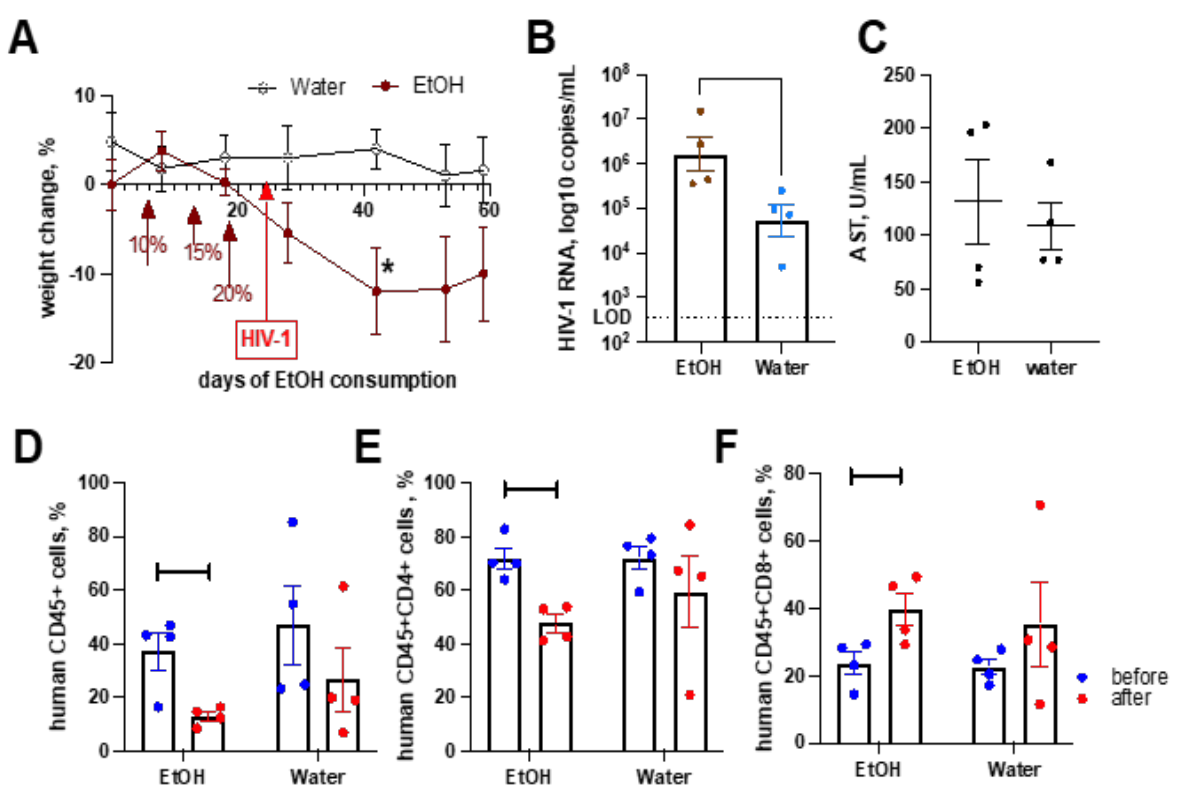
Figure 7. Alcohol consumption worsens HIV-1-induced immunopathology but does not change liver enzyme activity. ( A ) Humanized animals exposed to increased concentrations of alcohol in water showed a reduction in body weight compared to control mice kept on regular water. ( B ) Alcohol-consuming mice had a higher viral load in peripheral blood. ( C ) The activity of AST remained in the normal range, and ALT was the same at 49 U/mL in all animals. ( D – F ) Alcohol accelerated the development of immunopathology. The number of human cells in the peripheral blood of alcoholic mice dropped due to HIV-1 infection ( D ). The depletion of CD4+ cells ( E ) and increased CD8+ cell count ( F ) also was significant in ethanol-consuming animals. ( B – F ) mean and SEM, and individual numbers are shown. Statistical significance was determined using GraphPad Prism Version 9.4.1 by Mann–Whitney tests, and only significant changes are indicated: *— p < 0.05, Each group has 4